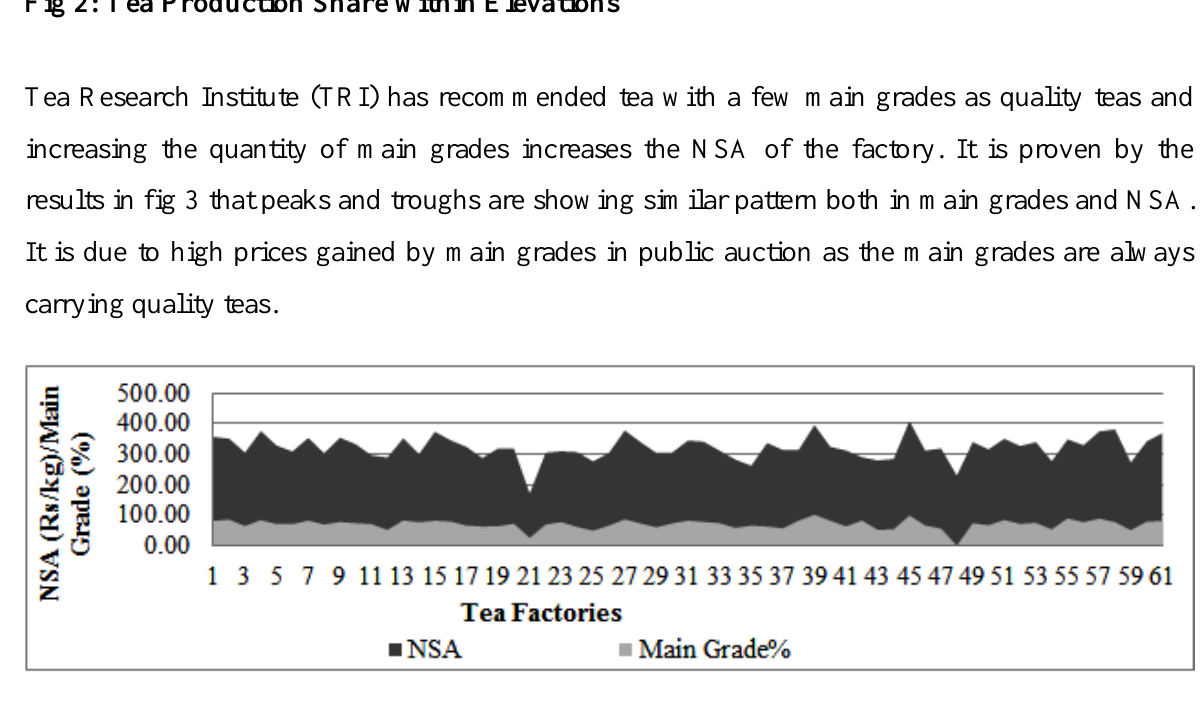
Fig 3: Distribution of NSA and Main Grade